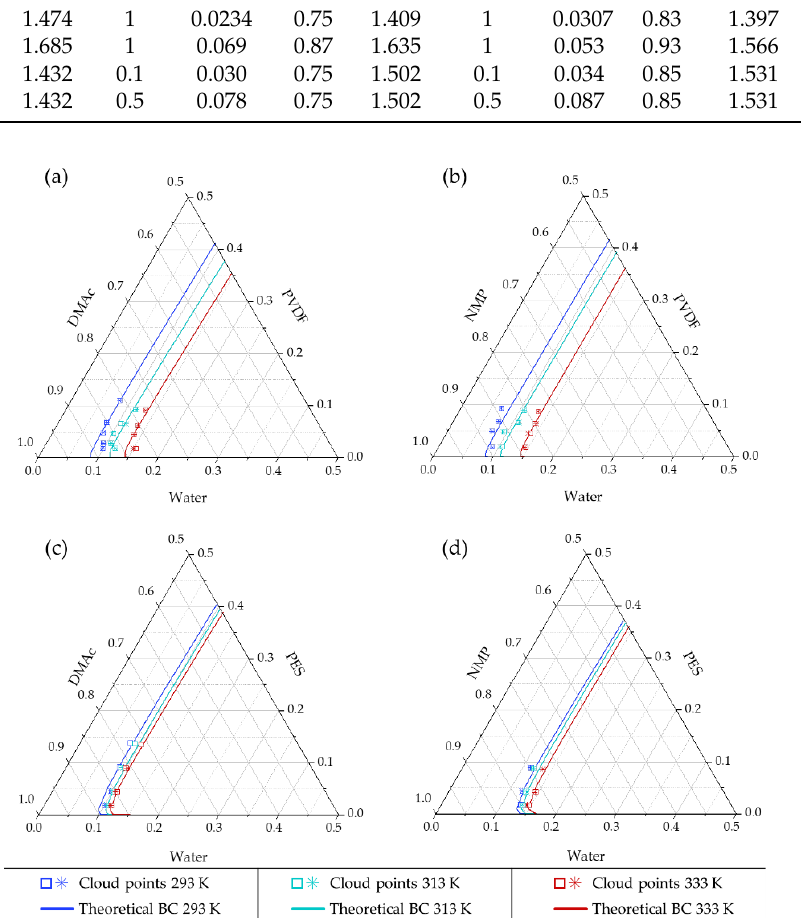
Figure 6. Cloud points and corrected theoretical binodal curves (BC) at 293, 313 and 333 K of ( a ) PVDF–DMAc–water, ( b ) PVDF–NMP–water, ( c ) PES–DMAc–water and ( d ) PES–NMP–water systems. Duplicated experimental results are represented by □ and*.